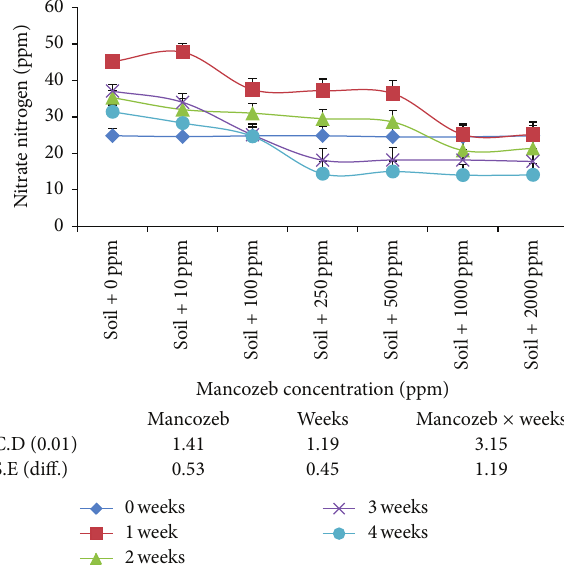
Figure1:Effectofmancozebonnitrificationof100 ppmofdiammo- nium hydrogen phosphate applied to